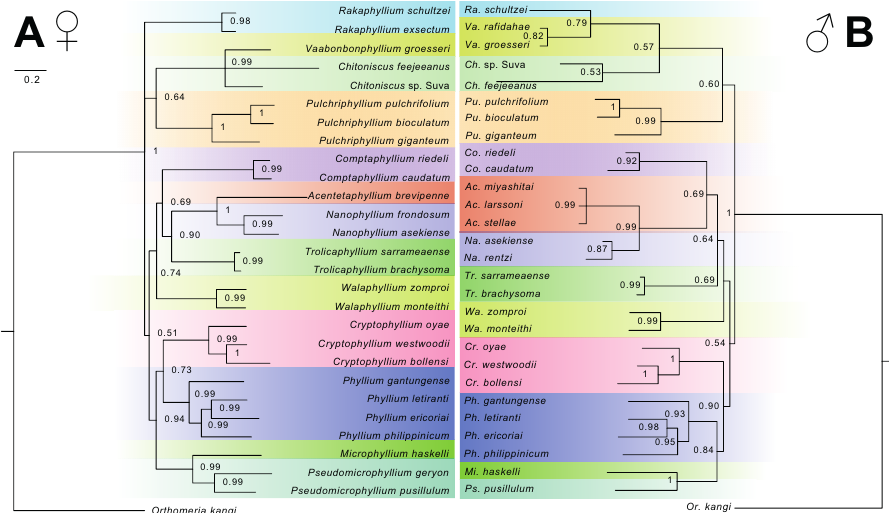
Figure 2. Phylogenetic reconstruction utilizing Bayesian Inference (BI) of representative taxa from all Phylliidae genera (morphology + DNA). Values presented are the posterior probability. Reconstruction based on a supermatrix of 4694 bp of molecular data and morphological characters (33 characters for females A and 25 characters for males B Branch length is proportional to relative divergence with the scale bar in the upper left indicating 0.2 units of divergence. Genera are color-coded to match between the female and male